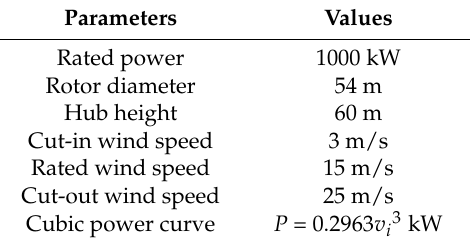
Table 1. Properties of the wind turbine model for the real offshore wind